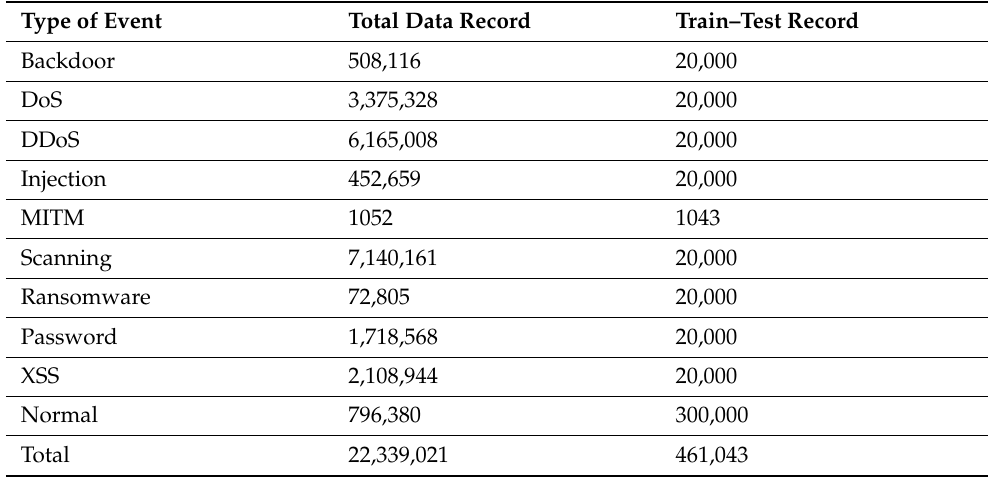
Table 2. The types and numbers of records in the entire ToN-IoT dataset and its testing and training sets.